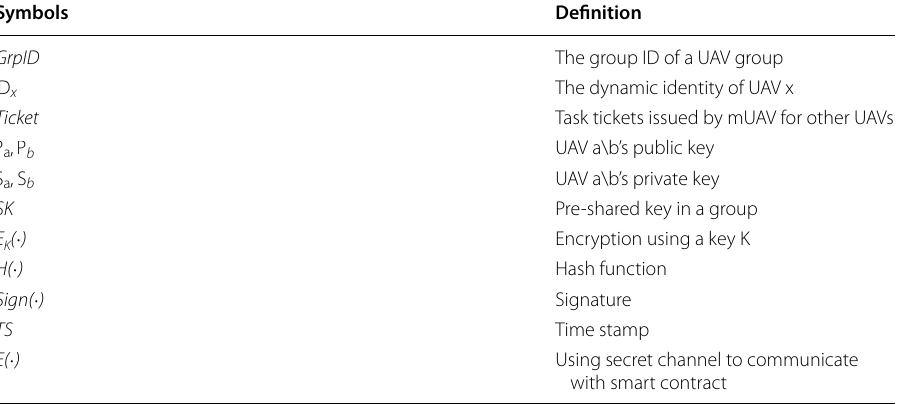
Table 1 Definition of symbols